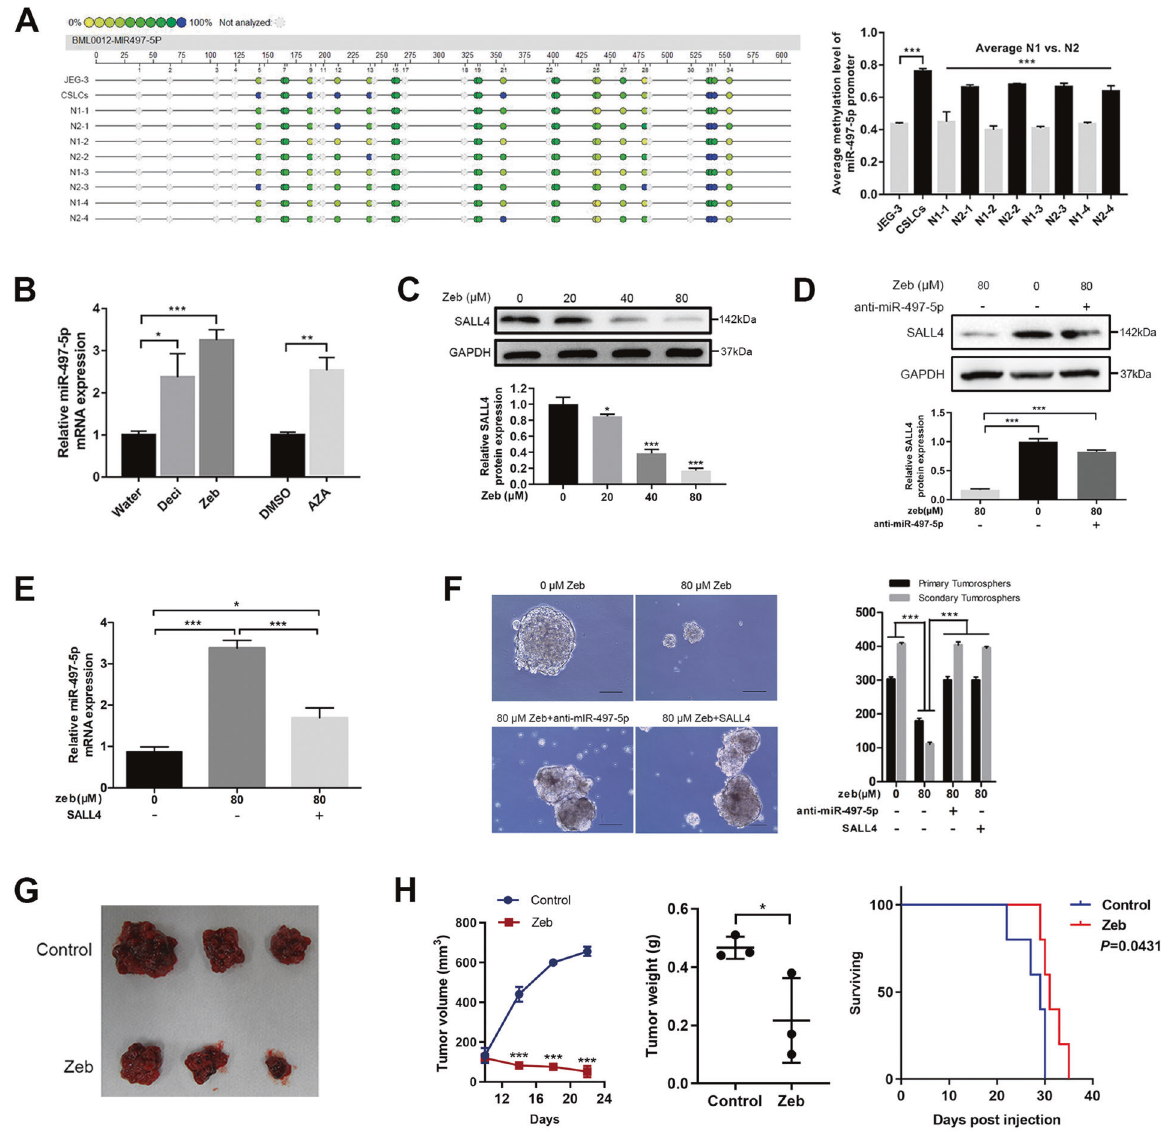
Fig. 5 DNA hypermethylation causes miR-497-5p silencing and suppresses choriocarcinoma CSLCs. A Pro fi ling of methylation levels of CpG sites in the miR-497-5p upstream region is presented as an epigram (left) and average methylation level of miR-497-5p promoter between the indicated groups (right). B qRT-PCR demonstrated miR-497-5p expression in CSLCs after treatment with decitabine, zebularine, or 5-zazcytidine for 7 days compared with control groups. C Western blot analysis of SALL4 protein levels (up) and quanti fi cation (bottom) with zebularine treatment. D Western blot analysis of SALL4 protein levels (up) and quanti fi cation (bottom) with zebularine treatment and anti- miR-497-5p. E qRT-PCR demonstrated miR-497-5p expression in CSLCs after treatment with 80 μ M zebularine and overexpressed SALL4 compared with control groups. F Representative images of sphere (left, magni fi cations: ×100) and sphere counts (right) with different groups. G Xenograft tumor in nude mice treated with zebularine at 200 mg/kg/day for 10 days. H Tumor volumes were measured every 4 days for 3 weeks (left). Tumor weight in the mice with zebularine treatment (middle). Survival curve of tumor-bearing mice between the zebularine group and control group (right). Data represent mean ± SD from at least three independent experiments. * P < 0.05, ** P < 0.01, *** P <